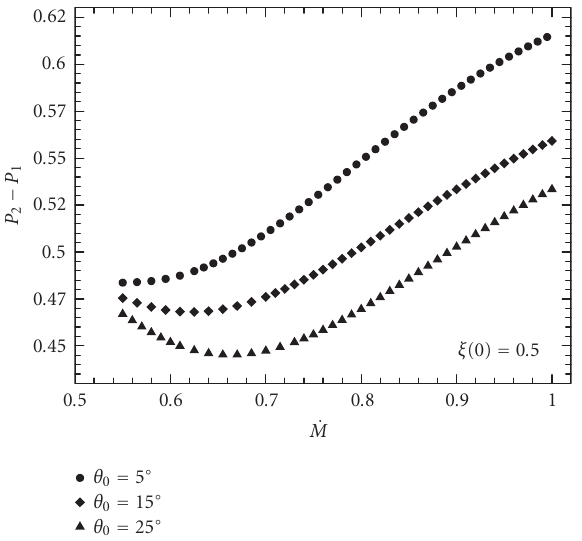
Figure 18: The simulated compressor characteristics at higher inlet size of distorted region of 0 . 5.